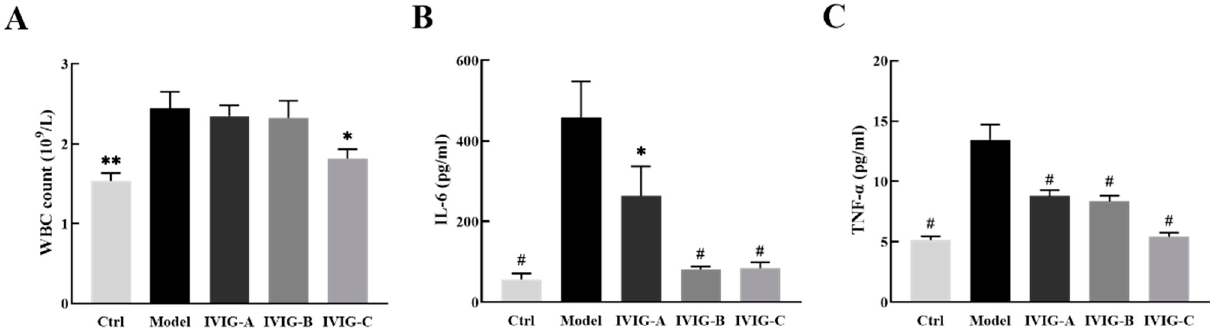
Figure 2. Effect of IVIG on WBC count in mice with LPS ( A ). More WBC counts were noted in the serum of Model group than that of Ctrl group and this increase was markedly attenuated after treatment with IVIG-A but not IVIG-B or IVIG-C. IVIG inhibits the release of ( B ) IL-6 and ( C ) TNF- α in LPS-stimulated Balb/c mice. Ctrl, control group; Model, LPS injection (Model) group; TNF- α , tumor necrosis factor- α ; IL-6, interleukin-6; Data are expressed as the mean ± SEM. Statistical significance using one-way ANOVA defined as * p < 0.05, ** p < 0.01, # p < 0.001 vs. Model group ( n = 6).